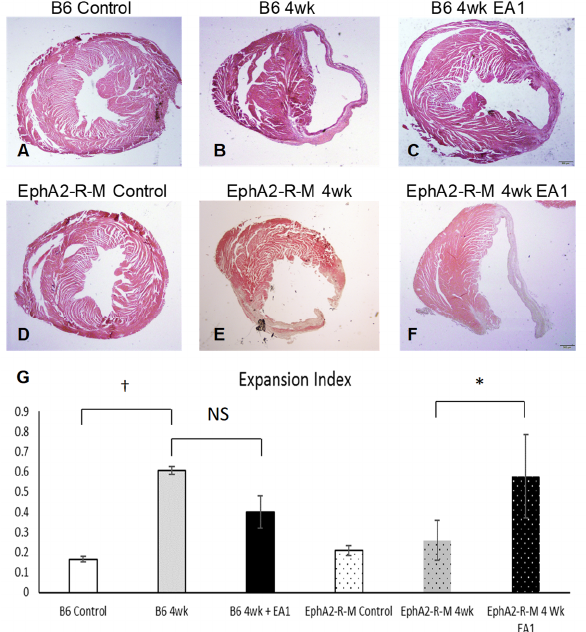
Figure 2. Hematoxylin and Eosin (H&E) Stains for Morphometric Analyses and Calculated Expansion Index in WT and EphA2-R-M Mouse Hearts. Representative H&E stains (20×) of WT ( A – C ) and EphA2-R-M ( D – F ) hearts used for morphometric determination of left ventricular remodeling indices (left ventricular area, scar area and thickness, chamber area) demonstrating that EA1 had a nonsignificant tendency to reduce adverse remodeling in WT B6 mouse hearts, but actually worsened infarct expansion ( G ) in EphA2-R-M mouse hearts. B6 WT control ( n = 10), EphA2-R-M control ( n = 10), WT B6 (IgG-Fc 4w, n = 8), EphA2-R-M (IgG-Fc, n = 10), EA1-treated WT B6 ( n = 11) and ephrinA1-Fc-treated EphA2-R-M ( n = 4). Statistical significance * p < 0.05 and † p < 0.01).